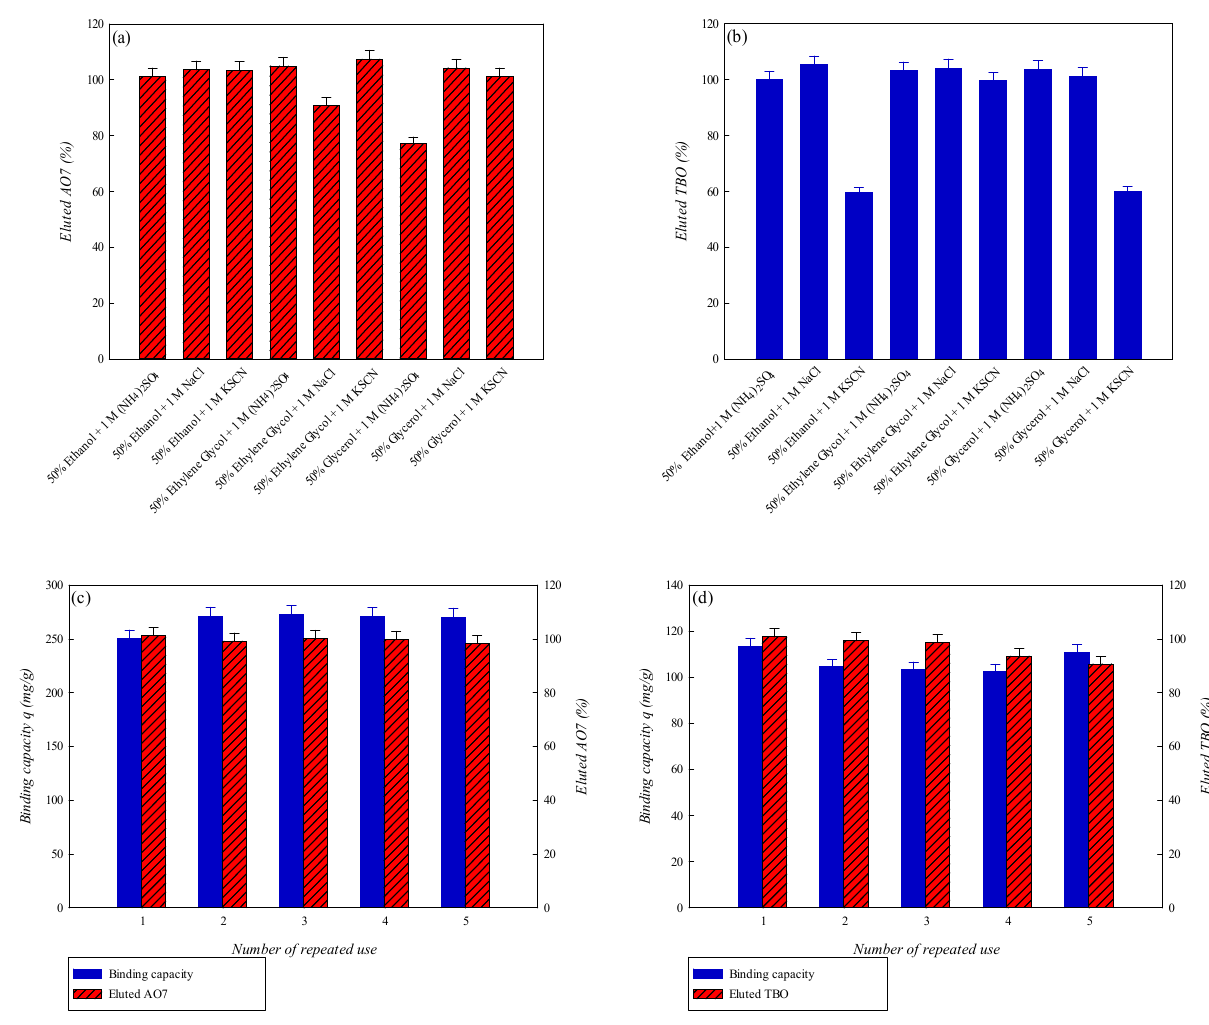
Figure 10. Adsorption–desorption, repeated use, and regenerated binding capacity of P-COOH-CS- CEW nanofiber membrane for the removal of AO7 and TBO dyes: ( a ) Eluted AO7 (%), ( b ) Eluted TBO (%), ( c ) Binding capacity for AO7 after repeated use, and ( d ) Binding capacity for TBO after repeated